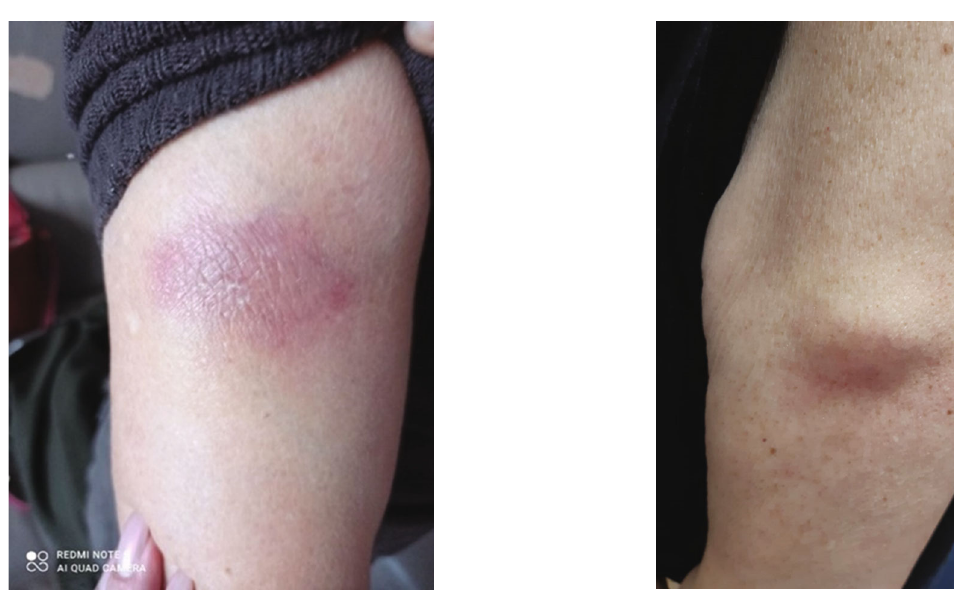
Figure 6: Skin rash 2 days after Parvulan injection. Improvement of the lesion after 10 days with the use of diclofenac gel.